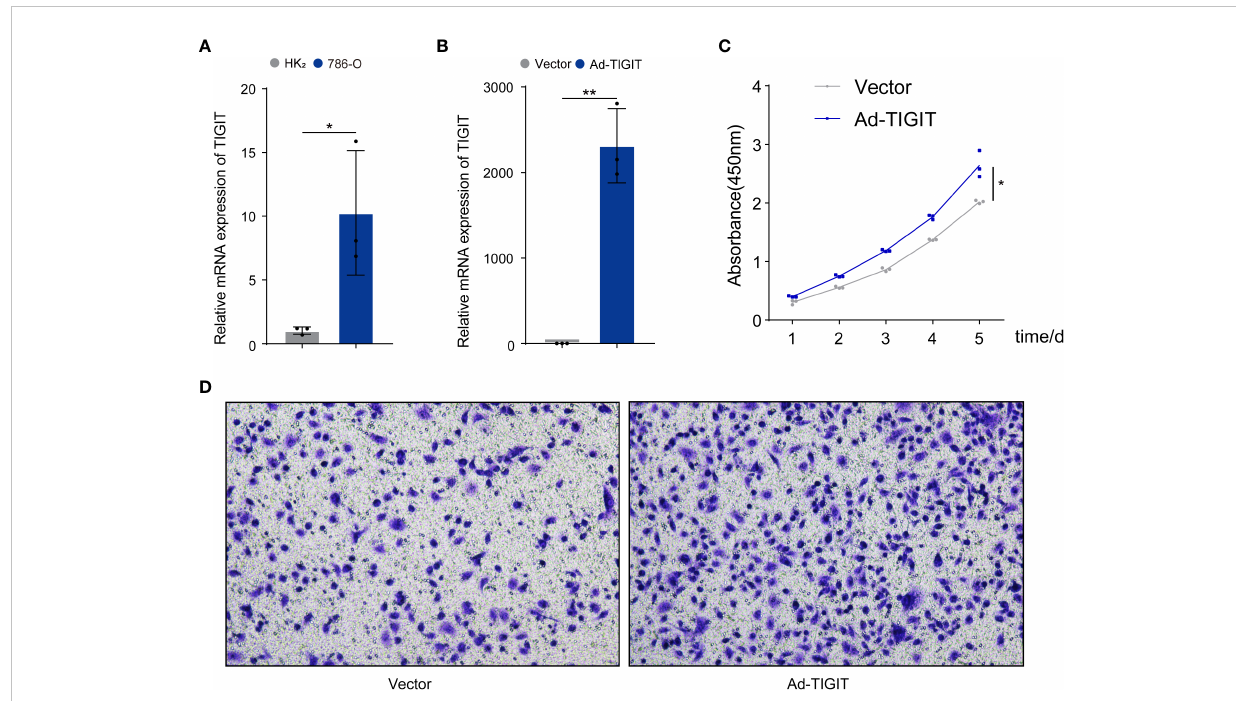
FIGURE 11 TIGIT affected the proliferation and migration of cells in renal carcinoma. (A) qRT-PCR was used to detect expression levels of TIGIT in tumor cells and normal cells. (B) The overexpression of TIGIT in 786-O cells was con fi rmed by qRT-PCR. (C) CCK8 assay: TIGIT could increase the viability of 786-O cells. (D) Transwell migration assay: TIGIT could promote the migration of 786-O cells. *p < 0.05; **p <